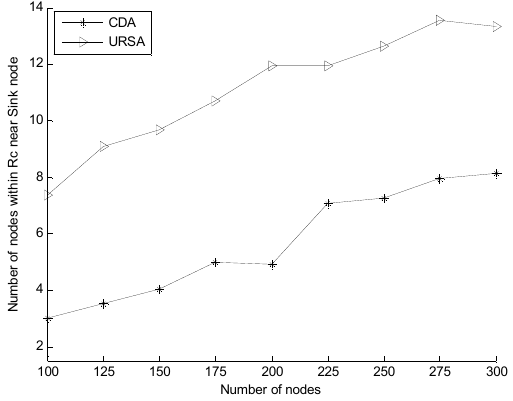
Figure 13. Comparison of the node number within the R c range of the sink node for a varying number of nodes.